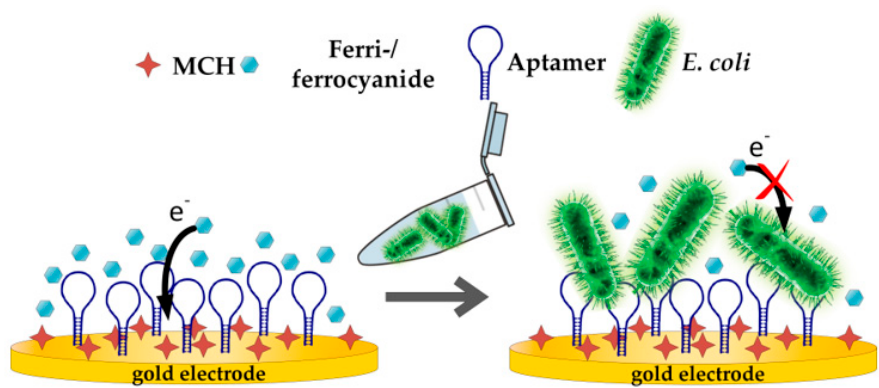
Figure 4. Schematic illustration of aptasensor experiment.